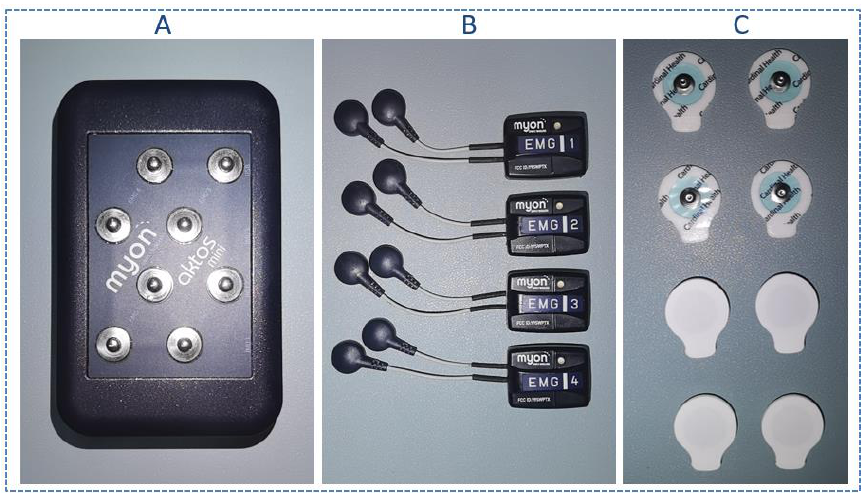
Figure 1. Myon Aktos-mini EMG amplifier: ( A ) signal receiving module; ( B ) signal acquisition module; ( C ) the disposable gel electrodes.